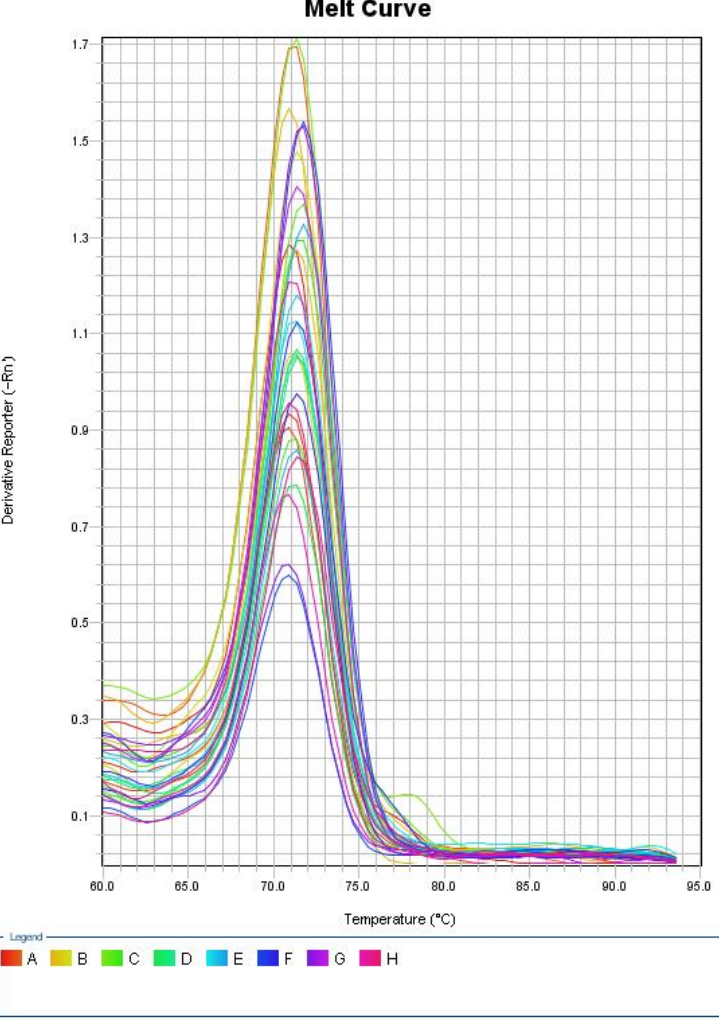
Figure 2. Melting curve for the first run.